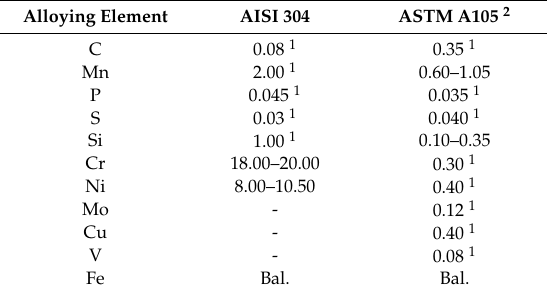
Table 1. Chemical composition of AISI 304 and ASTM A105 alloys.